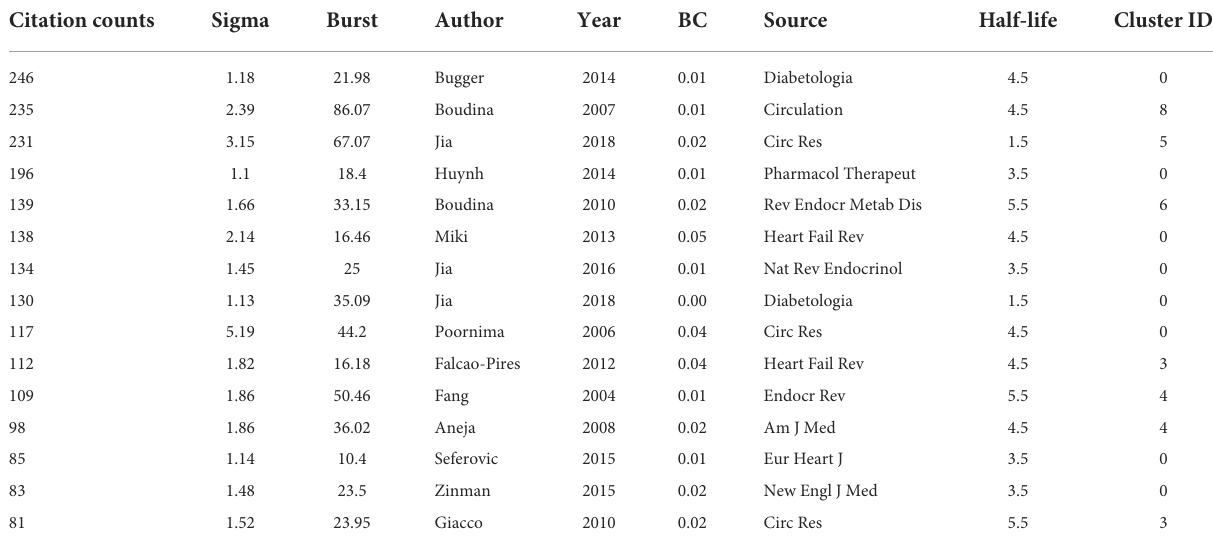
TABLE 2 Important diabetic cardiomyopathy references with high burst